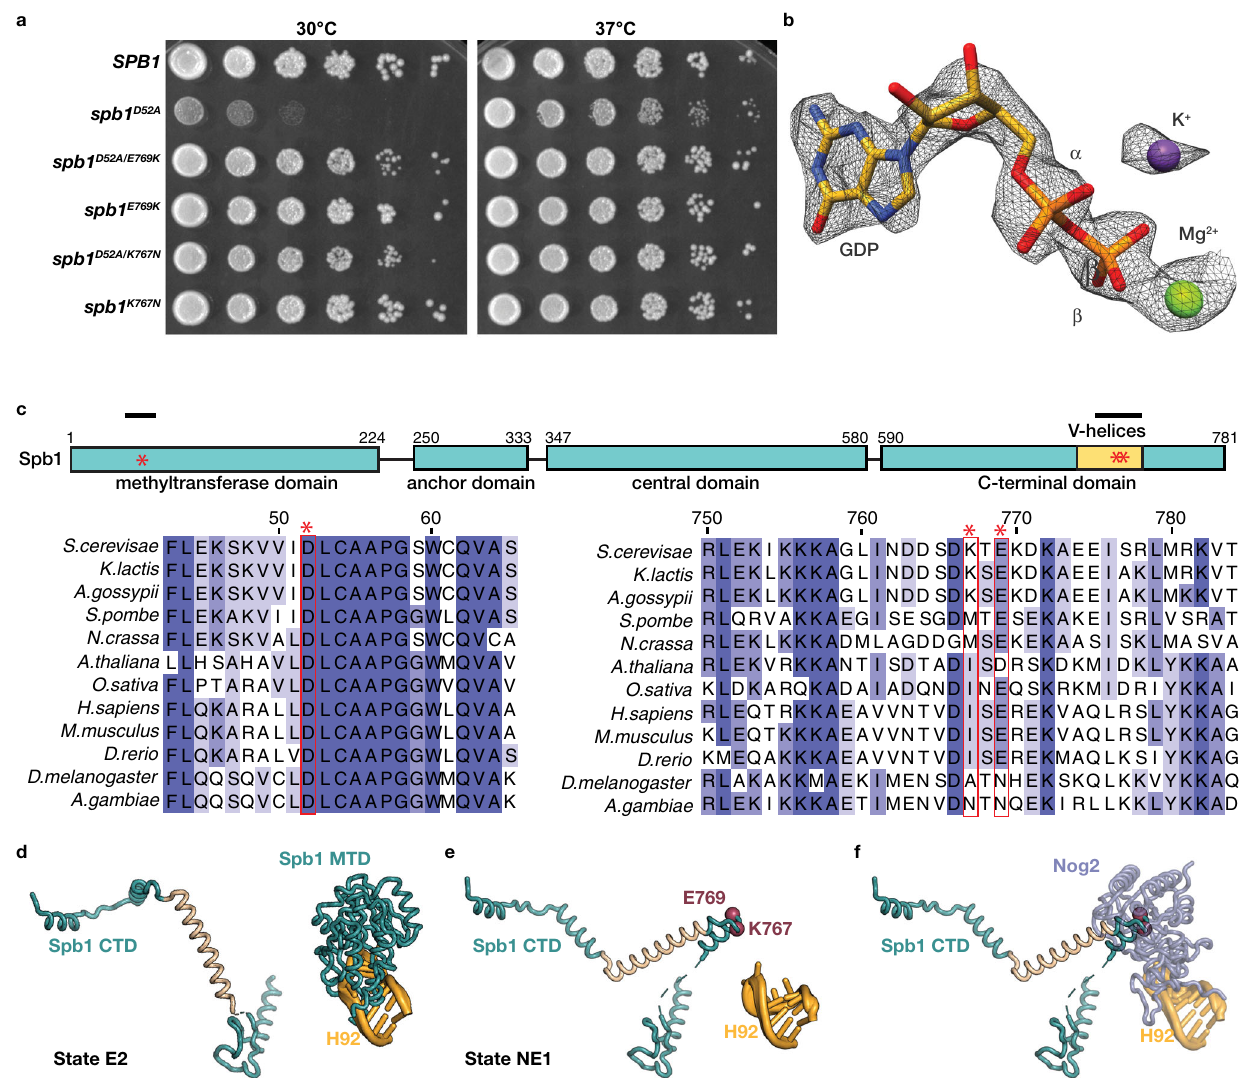
Fig.4 |SuppressormutationsintheC-terminaldomainofSpb1restoregrowth of spb1 D52A in the absence of G2922 methylation. a Spontaneous intragenic sup- pressorsof spb1 D52A rescue the slow growth phenotypeof spb1 D52A cells at30°Cbut do not in fl uence cell growth on their own. As previously reported, growth of spb1 D52A is restored at 37°C. b Map density in the Nog2 active site from Nog2 pre particles puri fi ed from the spb1 D52A/E769K strain, showing clear occupancy by GDP andindicatingthatnormal60Snucleoplasmicmaturationoccursinthepresenceof Nog2-GDP. c Domain schematic (top) of Spb1 showing the major segments of the protein as well as the position of D52 and of the suppressor mutations (red